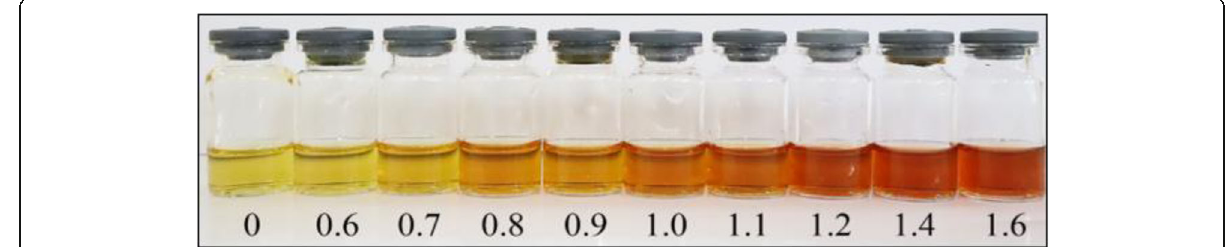
Fig. 4 Color changes in citrate-stabilized silver nanoparticles after addition of varying Ni 2+ concentrations (mM)